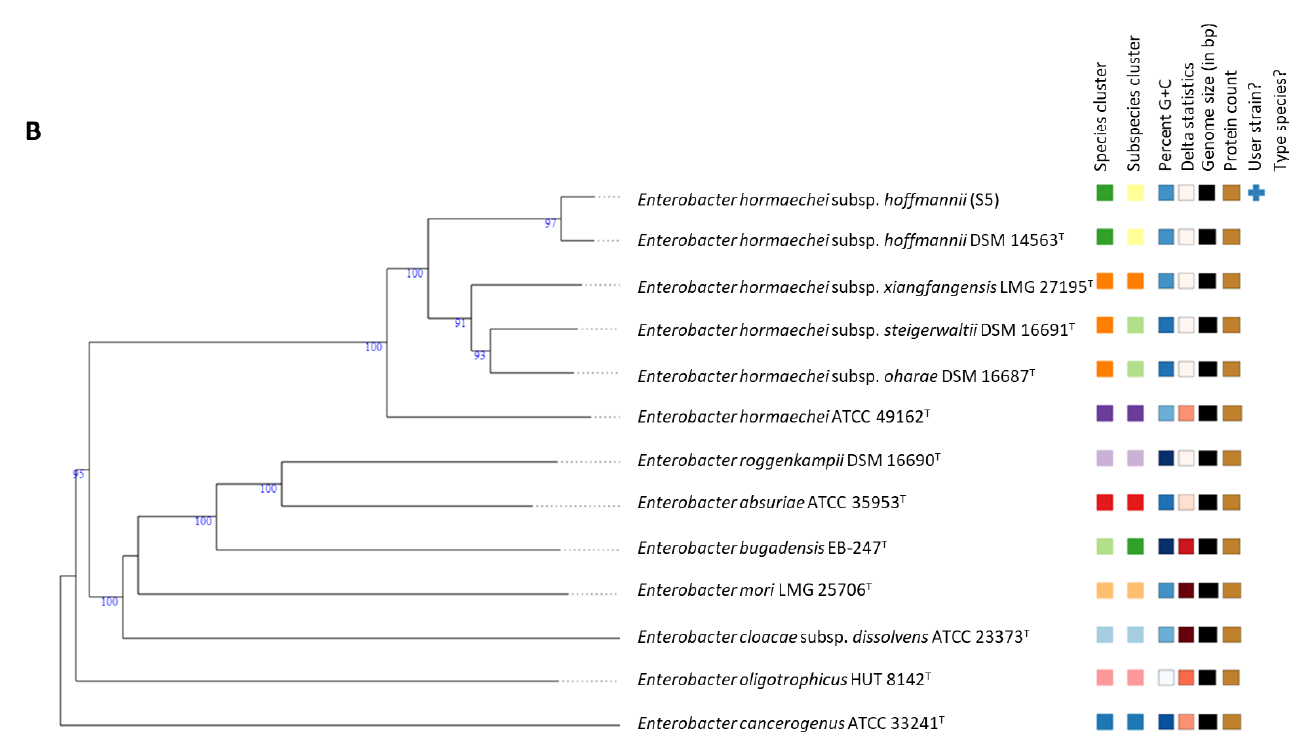
Figure 1. Trees inferred with FastME 2.1.6.1 from the Genome Blast Distance Phylogeny (GBDP) distances calculated from whole-genome sequences. Isolates S4 ( A ) and S5 ( B ) form a species cluster with Enterobacter hormaechei subsp. hoffmannii, having a dDDH of >70%, a clear indication that the isolates belong to the same species as E. hormaechei subsp. hoffmannii . Table 2. Type Strain Genome Server calculation of digital DNA–DNA hybridizations of isolates (S4, S5), and some of their closely related type strains.